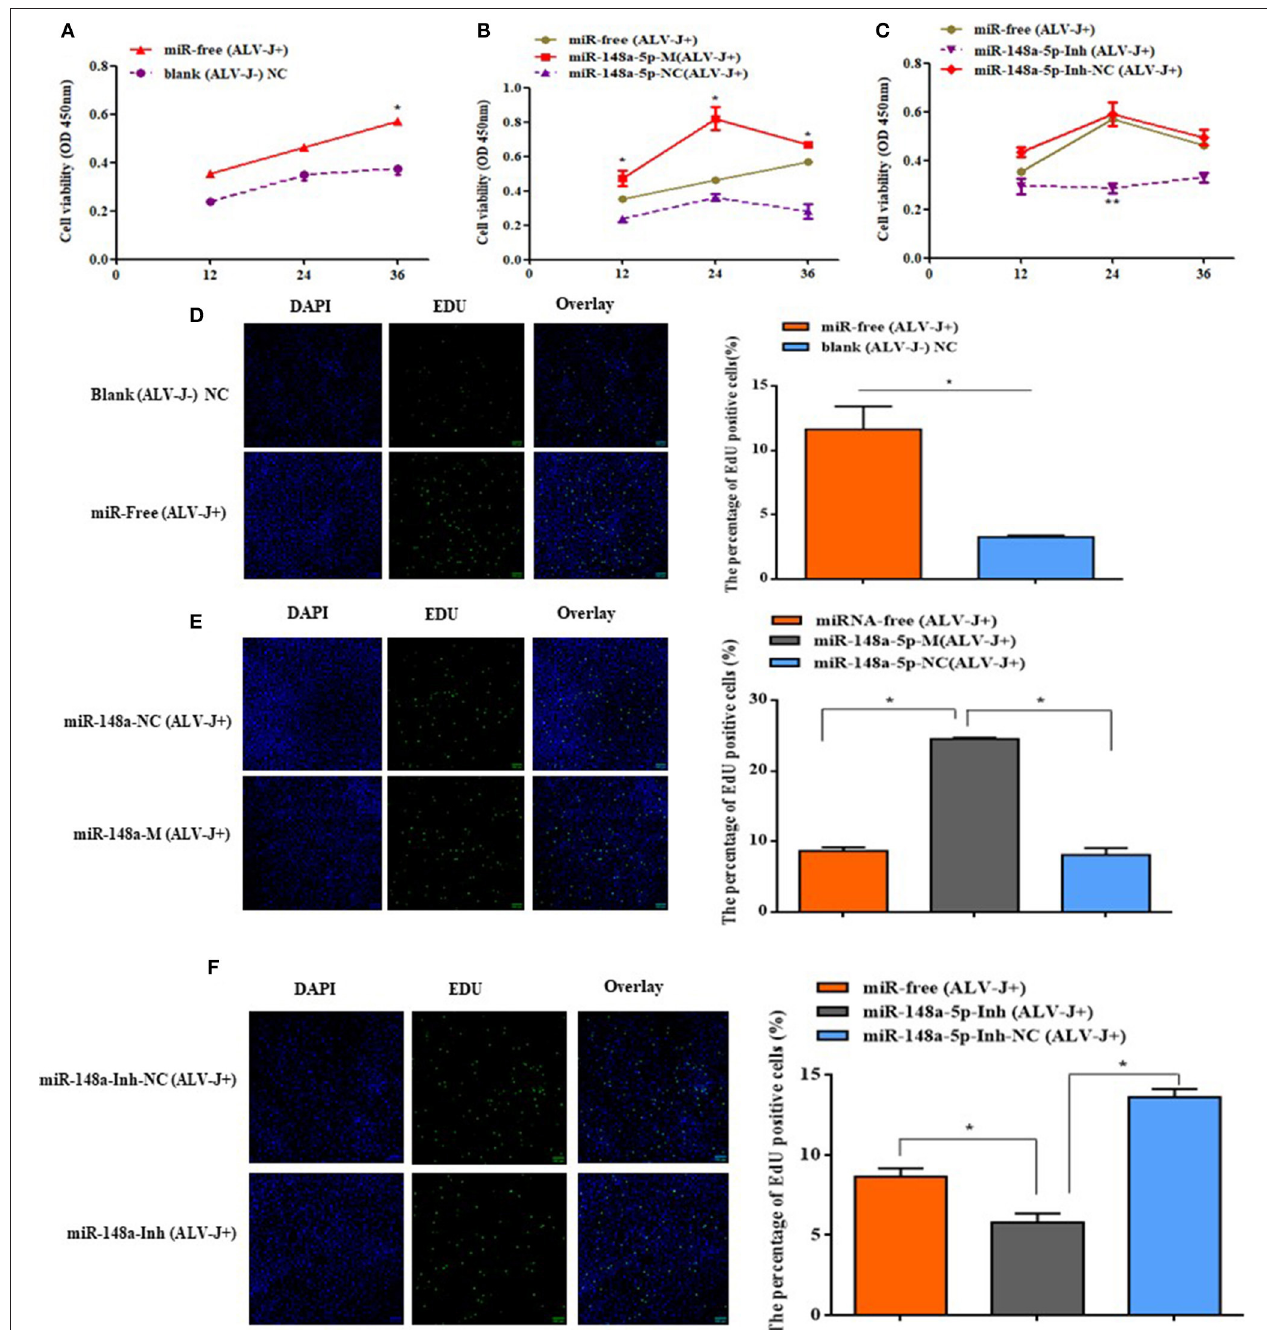
FIGURE 7 | Cell proliferaction was influenced by gga-miR-148a-5p. (A) Cell multiplication was promoted with ALV-J affection. (B,C) Effect of gga-miR-148a-5p on ALV-J-infected CEF cell proliferation. Cell proliferation was detected by a CCK-8 assay at 12, 24, and 36h after transfection, and then 36h of ALV-J postinfection, with the gga-miR-148a-5p mimics, inhibitor, and respective NC ( n = 3). (D) EdU assay for CEF infected with ALV-J; (E,F) EdU assay for CEF transfected with gga-miR-148a-5p mimic, inhibitor, and respective NC. EdU (green) fluorescence is used as an indicator of proliferation, and nuclei are indicated by DAPI (blue) fluorescence; micrographs were taken using × 200 magnification. All the error bars represent the means ± SEM of triplicated experiments. * P < 0.05.